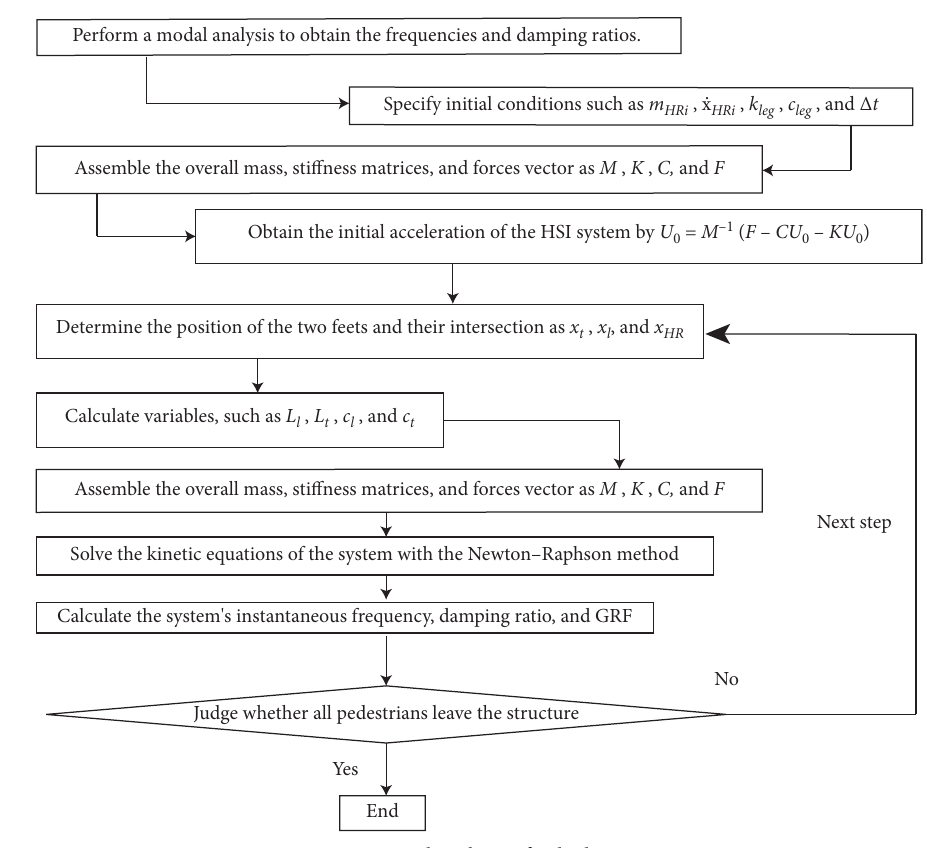
Figure 2: Flowchart of calculation.